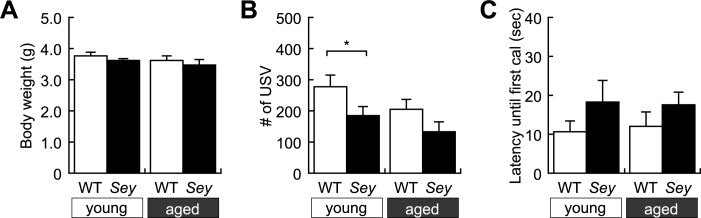
Ultrasonic vocalization of WT and Sey/+ mouse pups.USV of each mouse pup was recorded during maternal separation on postnatal day 6. Histogram showing results of (A) body weight; two-way ANOVA: no main effect of “genotype”; F = 2.269, p = 0.136, “father’s age”; F = 2.129, p = 0.148, and interaction (father’s age x genotype); F = 0.024, p = 0.876, (B) number of USV calls; two-way ANOVA: main effect of “genotype”; F = 6.467, p = 0.013, but no main effect of “father’s age”; F = 3.465, p = 0.066 and interaction (father’s age x genotype); F = 0.110, p = 0.741, and (C) latency until first USV calls; two-way ANOVA: no main effect of “genotype”; F = 2.513, p = 0.117, “father’s age”; F = 0.005, p = 0.944, and interaction (father’s age x genotype); F = 0.057, p = 0.812, in WT and Sey/+ mouse pups born to young (3M) or aged (>12M) father. All data are presented by the mean ± SEM. *p < 0.05, versus WT littermate, determined by Bonferroni post hoc test. WT: wild type, Sey: Pax6 mutant.